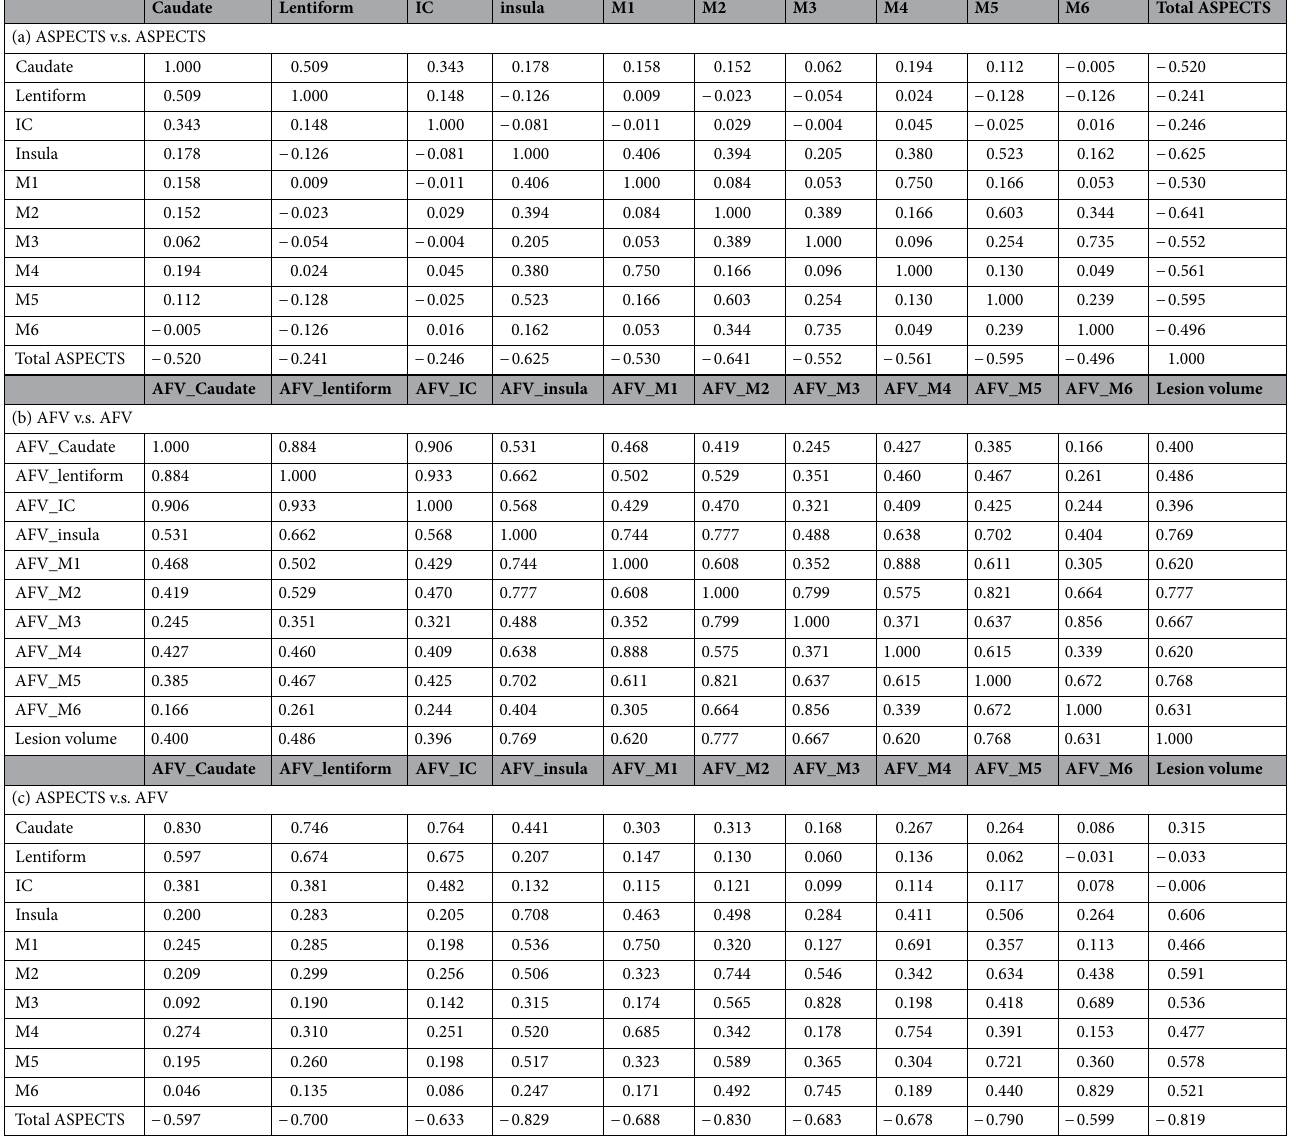
Table 2. Correlation matrices of the visual ASPECTS and the ASPECTS feature vectors, AFVs. Note the high correlation in spatially neighbor regions found between visual ASPECTS (a) and between AFVs (b). Note that the highest correlation between visual ASPECTS and AFVs (c) is mostly found in the corresponding highest AFV component for each region, followed by the spatially neighboring